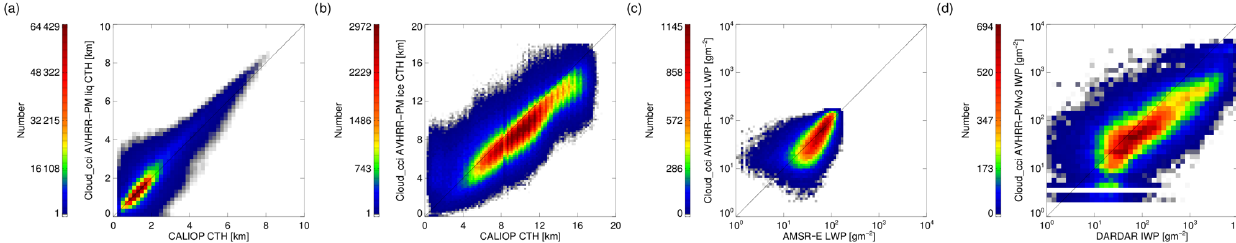
Figure 3. Two-dimensional frequency distributions of AVHRR-PMv3 cloud properties ( a : cloud-top height – CTH – of liquid clouds; b : cloud-top height of ice clouds; c : liquid water path – LWP; d : ice water path – IWP) collocated with corresponding reference products of CALIOP, AMSR-E and DARDAR.